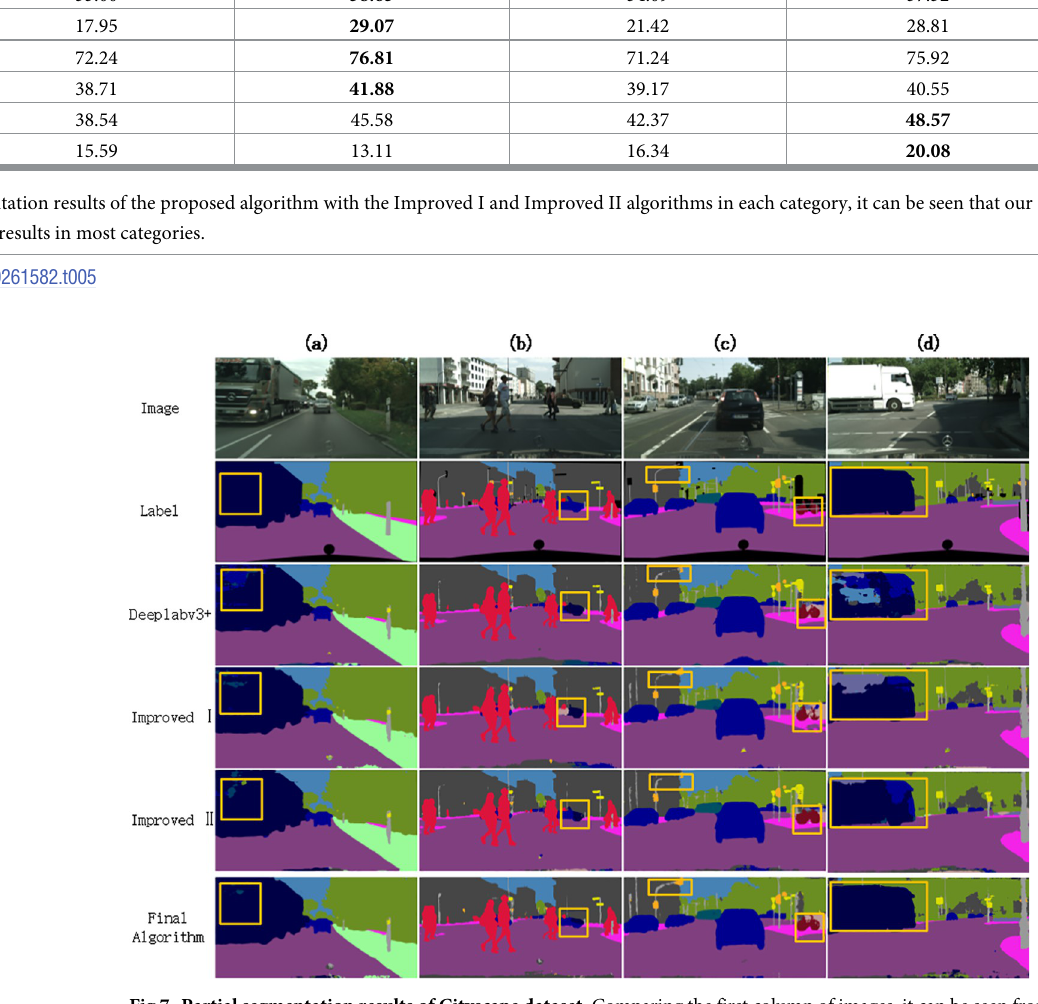
Fig 7. Partial segmentation results of Cityscape dataset. Comparing the first column of images, it can be seen from the labeled area of the yellow box in the figure that the truck head in the original algorithm segmentation result is mis- segmented, and the segmentation results of the Improved I and Improved II algorithms reduce the mis-segmented area. After applying two innovative methods at the same time, the segmentation area is minimized. In the second column of image labeling area, the original, Improved I, and Improved II algorithm segmentation results have the phenomenon of mis-segmentation of cars into trucks, and the proposed algorithm is more correct to segment the contours and categories of cars. In the third column of segmentation results, the bicycle contours in the original algorithm and the Improved I are relatively fuzzy. In addition, there is a problem of discontinuous segmentation of street lights, and the proposed algorithm can get a clear bicycle contour shape. In the fourth column of images, it can be seen that part of the truck area in the original algorithm was mistakenly divided into cars and sky categories. The Improved I and the Improved II algorithm reduced the mis- segmented area, and the proposed algorithm segmented the truck area completely and correctly.